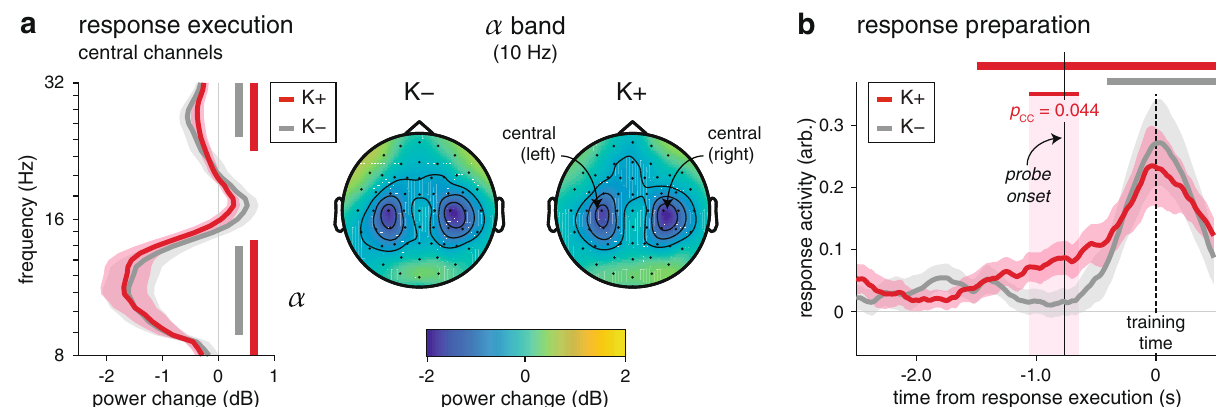
Fig. 6 Premature response preparation under ketamine. a Suppression of alpha power at central channels during response execution. Left: power change ( x axis) between 8 and 32 Hz (y-axis) between response execution and the preceding stimulus sequence at central sites. The power suppression peaking in the alpha band (10 Hz) is identical between conditions. Right: spatial topography of the suppression of alpha power during response execution. The suppression of alpha power peaks at bilateral central channels overlying human motor cortex, and is identical between conditions. b Time course of alpha power projected on the response-predictive axis (response activity) in the last 2.5 s preceding response execution. Response activity predicts the upcoming response well before the “ go ” signal (probe onset) under ketamine (red curve), but not placebo (gray curve). Response activity is stronger under ketamine surrounding the onset of the “ go ” signal (indicated by the red-shaded area, two-sided t tests corrected for multiple comparisons across time). Shaded error bars indicate s.e.m. ( N = 18 participants). Source data are provided as a Source Data fi